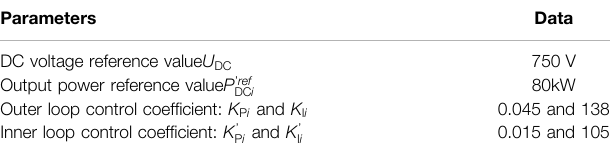
TABLE 1 | Parameters of response characteristic